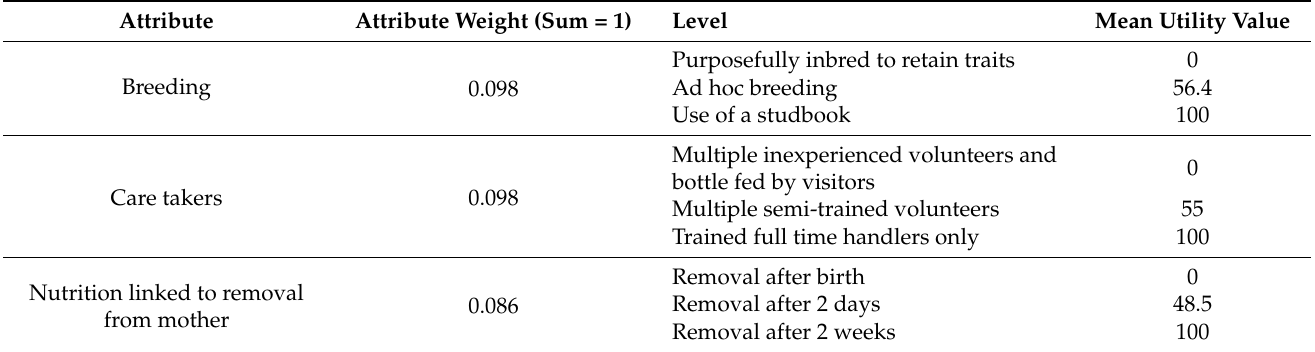
Table 3. The normalized attribute weights and the mean utility values for all the levels within each attribute, with 0 as the least preferred and 100 as the most